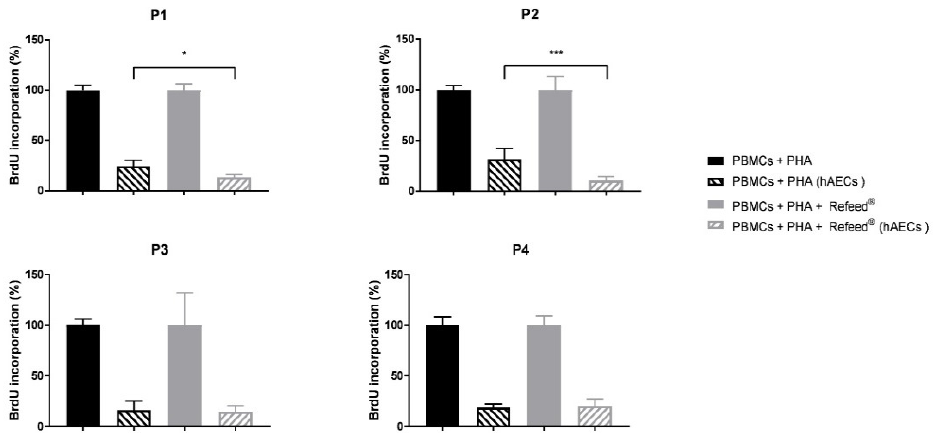
Figure 9. Percentage of bromodeoxyuridine (BrdU) incorporation in Peripheral Blood Mononuclear Cells (PBMCs) co-cultured with human Amniotic Epithelial Cells (hAECs), with and without Refeed ® supplementation. hAECs were co-cultured with phytohemagglutinin (PHA)-activated PBMCs for 72 h in basal medium (PBMCs + PHA (hAECs)) or in basal medium supplemented with Refeed ® (PBMCs + PHA + Refeed ® (hAECs)). PBMC proliferation was analyzed evaluating the percentage of BrdU incorporation. Positive controls were represented by activated PBMCs cultured in basal medium (PBMCs + PHA) and in basal medium supplemented with Refeed ® (PBMCs + PHA + Refeed ® ) without hAECs. Each percentage of BrdU incorporation of co-cultures was normalized with respect to their positive control, set at 100%. Results are expressed as mean of percentage of BrdU incorporation ± standard deviation (SD) (* p < 0.05, *** p < 0.001). The experiment was performed on three human samples in technical triplicate.